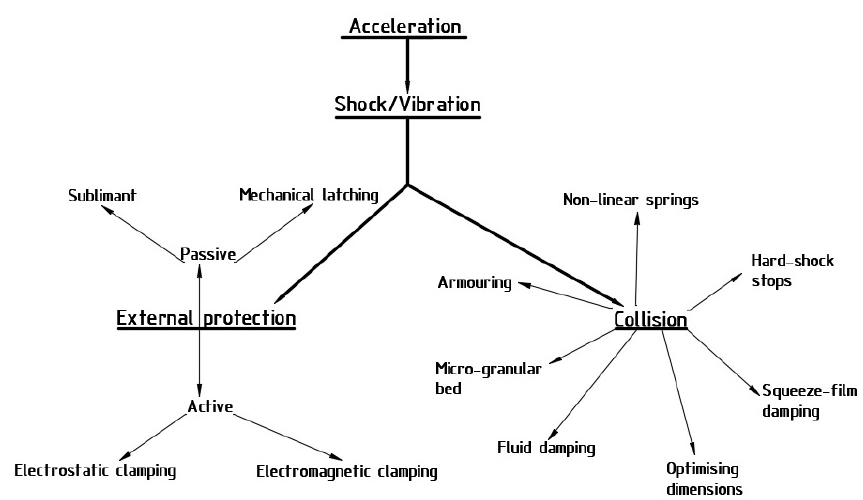
Figure 12. Shock protection for RF MEMS switches.